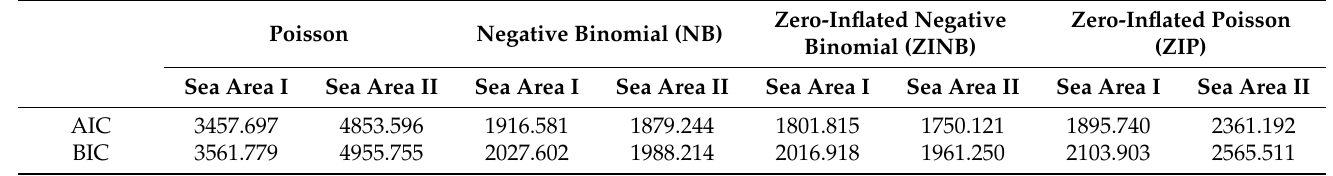
Table 3. Goodness of fit test results for different regression